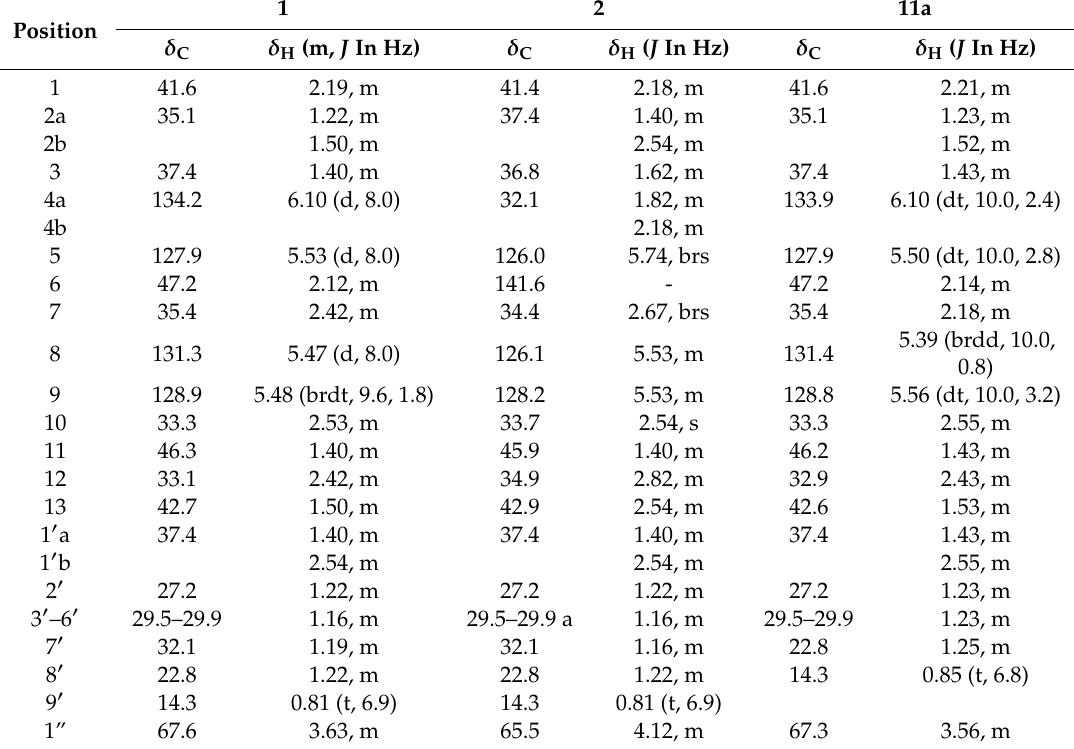
Table 1. 13 C–NMR and 1 H–NMR data of compounds 1 , 2 (150 and 600 MHz), and 11a (100 and Table 1. 13 C NMR and 1 H NMR data of compounds 1 , 2 (150 and 600 MHz), and 11a (100 and 400 400 MHz) in CDCl 3 MHz) in CDCl 3 .